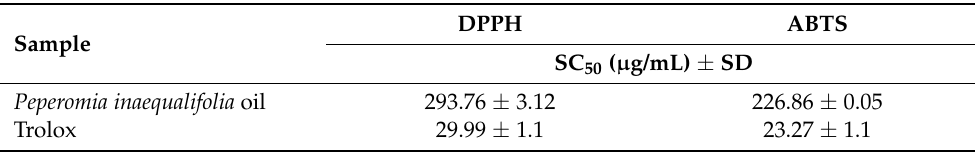
Table 5. Antioxidant activity of essential oil from Peperomia inaequalifolia